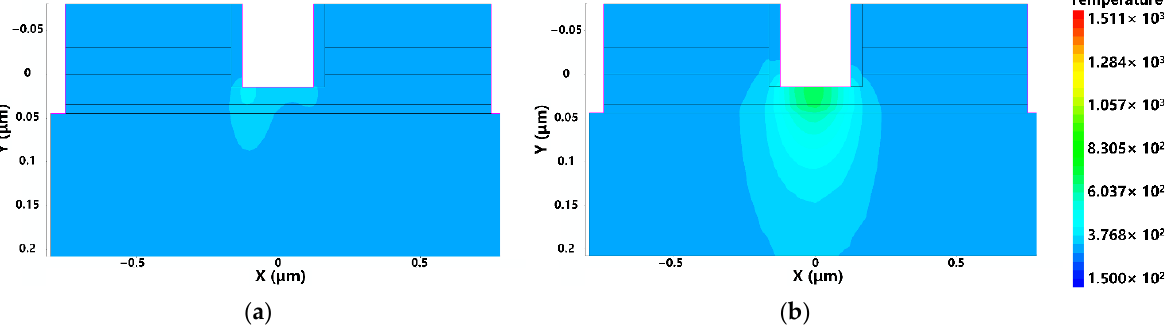
Figure 8. The distributions of temperature: ( a ) 1.0 ns; ( b ) 1.4 ns.